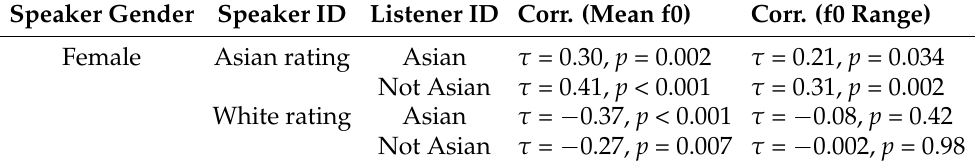
Table 1. Correlation test results ( τ = Kendall’s tau) for ethnic category ratings by vocal pitch properties, split by speaker gender and listener racial/ethnic group. For female speakers, mean pitch (f0) correlated strongly with identification as both Asian and White, but pitch range did not. Male speakers demonstrated no correlation between vocal pitch properties and ethnicity